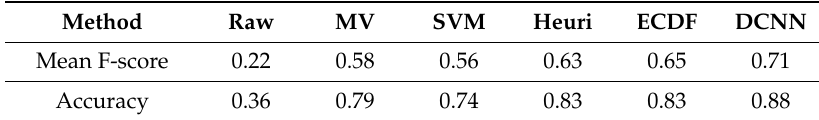
Table 1. Performance comparison between conventional methods and the DCNN in supervised learning. MV: statistical meta value of raw data; SVM: support vector machine; ECDF: empirical cumulative distribution